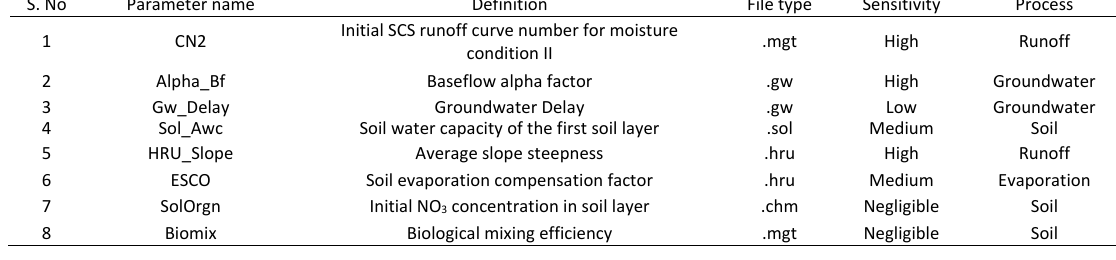
Table 3: Sensitivity of the parameters for the streamflow value of the Manipur River basin S. No